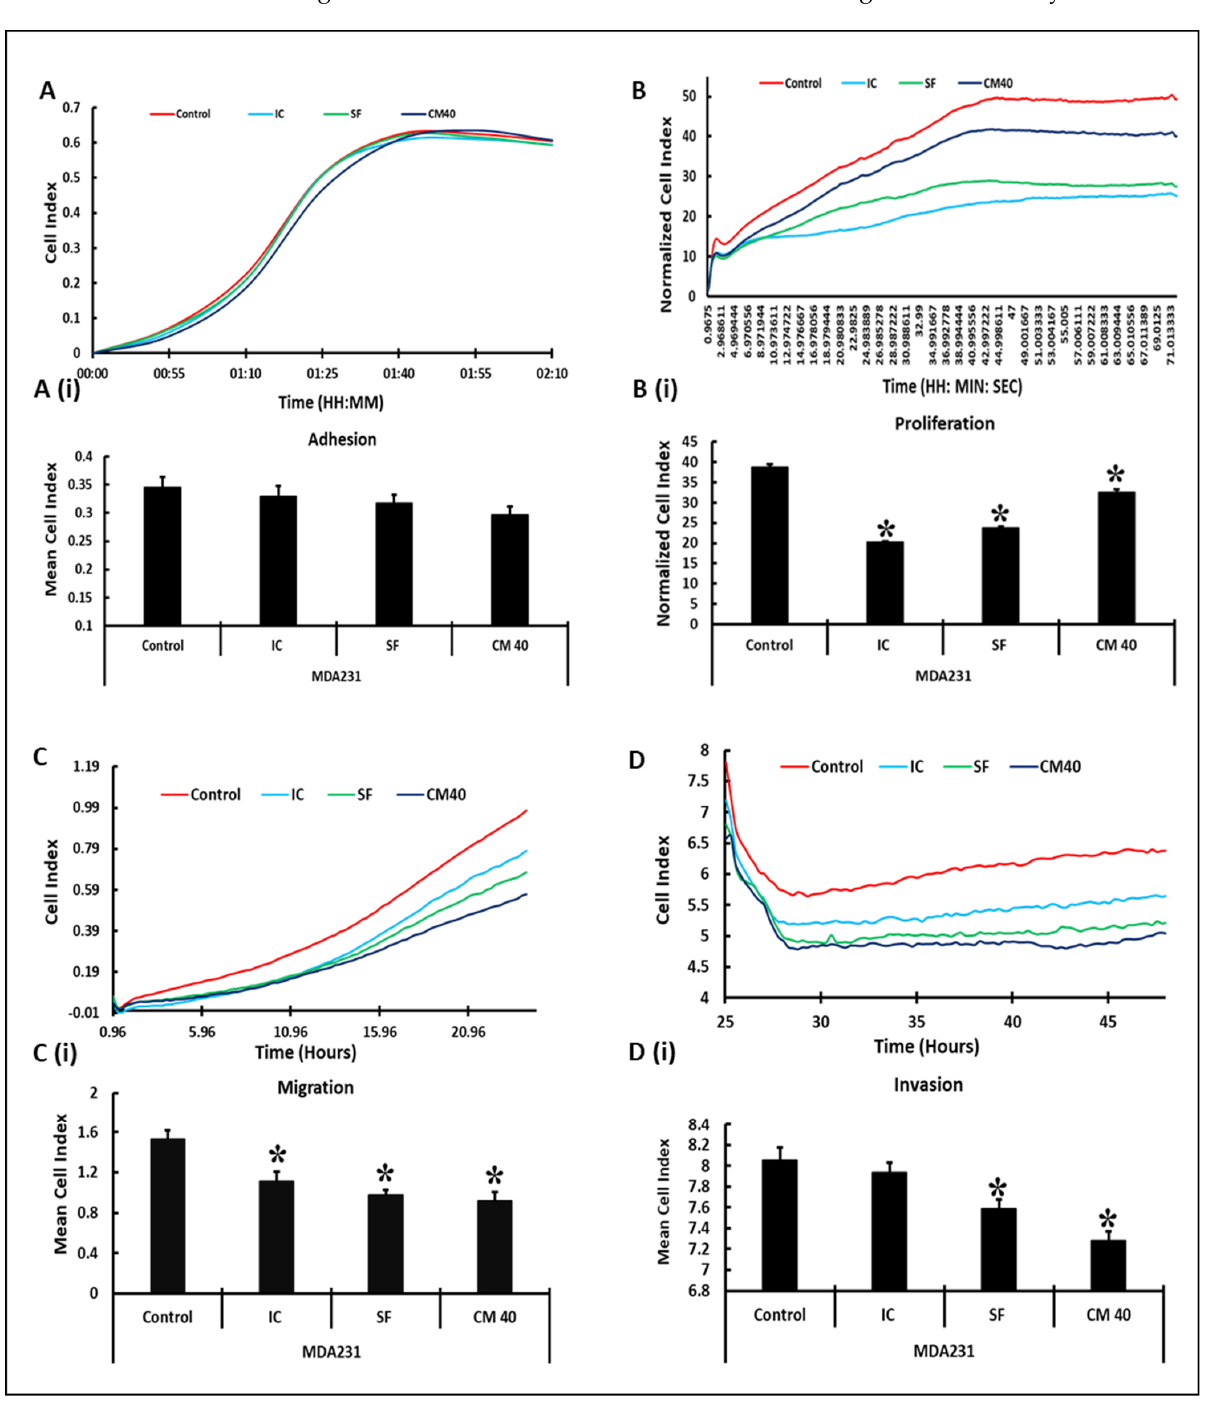
Figure 2. Effect of DPMSCs on MDA231 cell functions: MDA231 cell functions pertaining to cellular adhesion, proliferation, migration, and adhesion, as evaluated by an xCELLigence RTCA system. In response to 1:1 (DPMSCs:MDA231 cells) cellular ratios in the SF setting, and at 40% CM of DPMSCs, MDA231 cell adhesion decreased as compared to the IC setting and the untreated control (( A ) and ( A ( i ))). The proliferation of MDA231 cells decreased significantly after treatment with DPMSCs at a 1:1 ratio in IC and SF settings, as well as when treated with 40% CM, as compared to the untreated control (( B ) and ( B ( i ))). MDA231 cell migration decreased significantly when treated with the cellular component of DPMSCs in both IC and SF settings, as well as when treated with the CM of DPMSCs, as compared to the untreated control (( C ) and ( C ( i ))). The invasion of MDA231 cells did not change significantly when treated with DPMSCs in the IC setting, but in the SF setting as well as after treatment with 40% of CM the invasiveness of MDA231 cells decreased significantly as compared